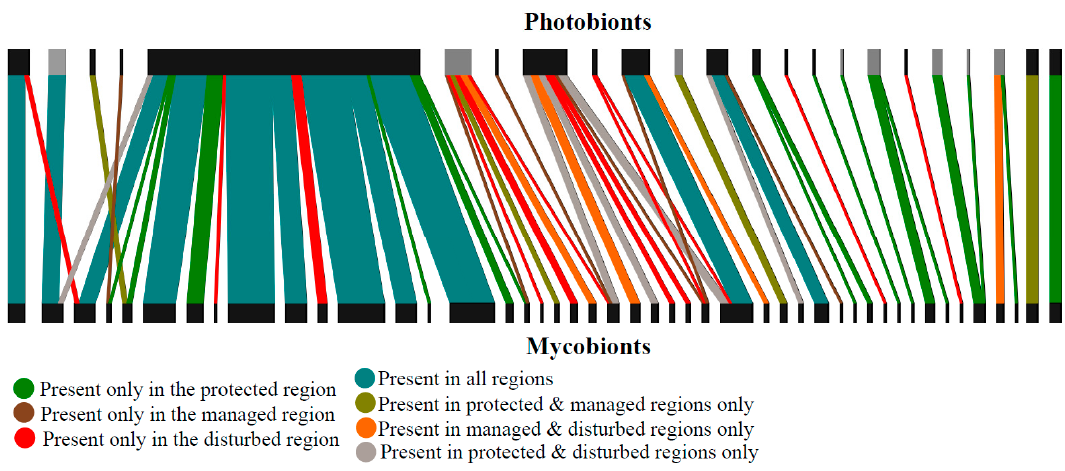
Figure 2. Association network based on fungal and algal ITS sequences, given a 97% similarity BLASTn threshold. Black and grey horizontal bars on the top represent Trebouxia and Trentepohlia OTUs respectively. Colored vertical bars represent fungal algal associations.